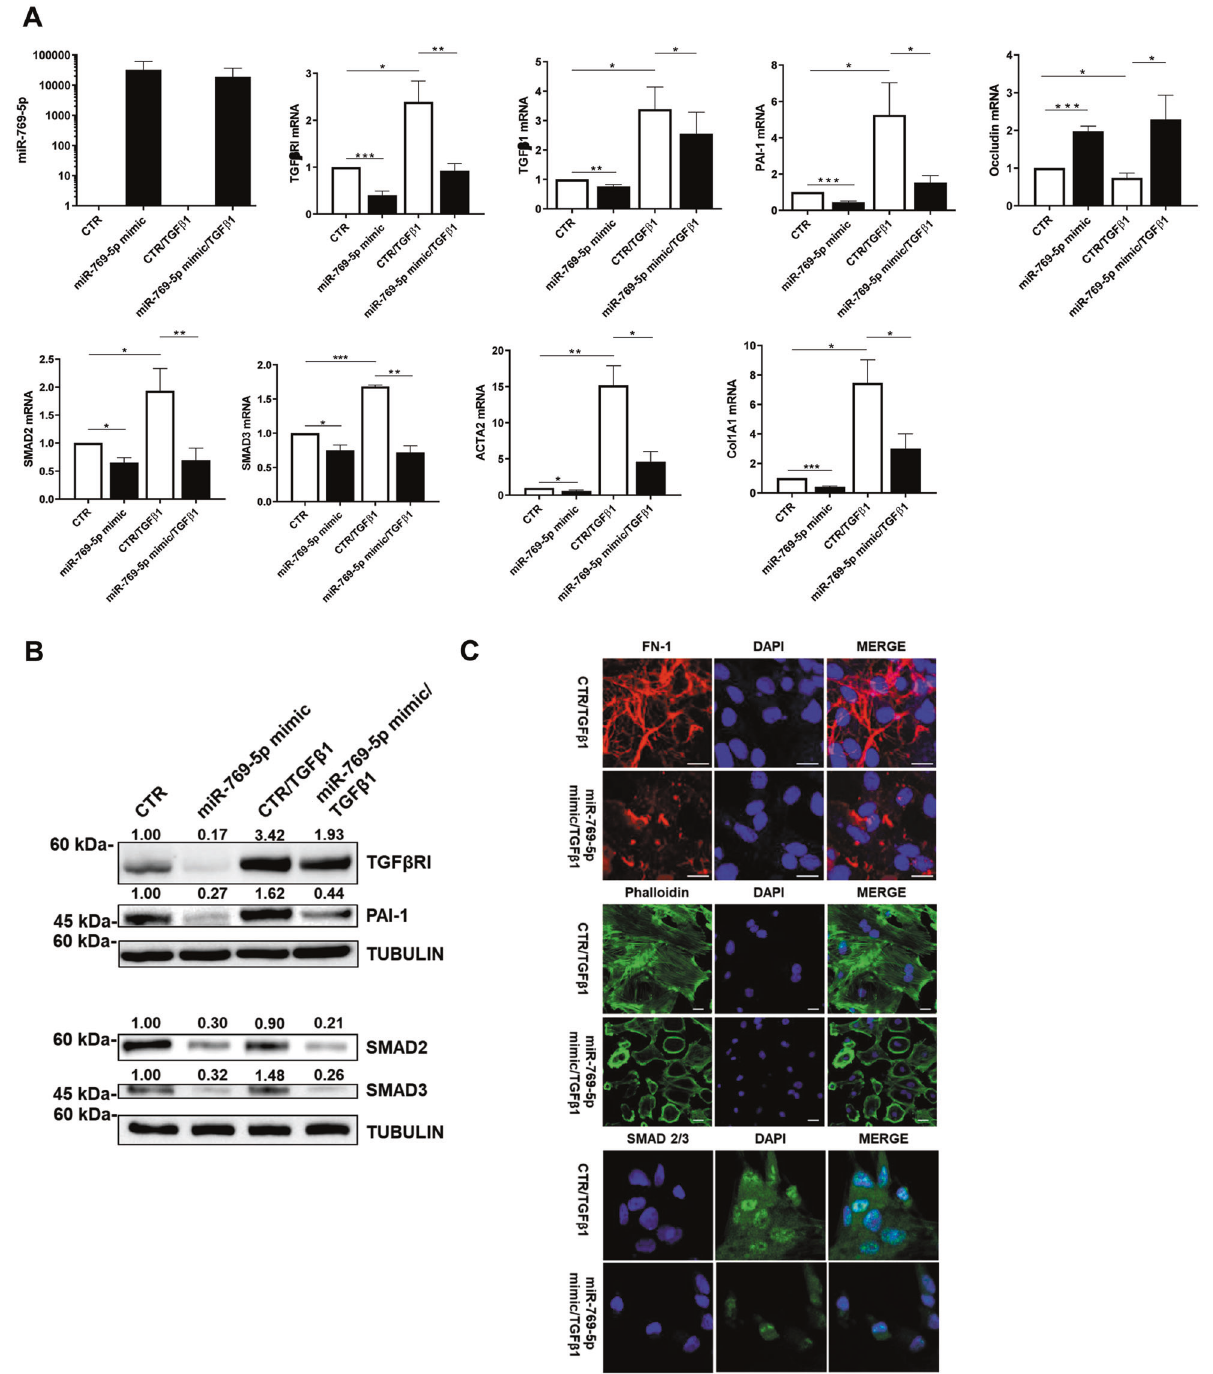
Fig. 3 miR-769-5p ectopic expression is suf fi cient to inhibit TGF β 1-induced expression of MMT molecular markers. A RT-PCR experiments showing the expression of miR-769-5p and of TGFBRI, TGF β 1, PAI-1, Occludin-1, SMAD2, SMAD3, ACTA2, and Col1A1 mRNA upon ectopic expression of miR-769-5p. Quantitative RT-PCR was performed on total RNA. L34 mRNA levels were used for normalization. Bars represent the mean ± SEM of duplicate determinations in three to six independent experiments. B WB showing the expression of SMAD2, TGFBRI, SMAD3 and PAI-I upon ectopic expression of miR-769-5p. Tubulin was used as a loading control. Data are representative of three independent experiments. C Immuno fl uoresce of MCs from PD patients transfected with mimic miR-769-5p. Fixed cells were stained with antibodies against type I COLLAGEN, FN-1 and α -SMA. Data are representative of three independent HDAC1-mediated mesenchymal marker regulation. To demon- Confocal microscopy experiments demonstrated both the reac- strate a functional role of miR-769-5p in MC migration and quisition of an epithelial-like morphology and the downregulation invasion, miR-769-5p was either genetically silenced or ectopically of mesenchymal markers COLLAGEN I, FN-1 and α − SMA (Fig. 3C). expressed in MCs and analyzed in a scratch assay (Fig. 4A top and Overall, these observations pinpoint miR-769-5p, as pivotal in the